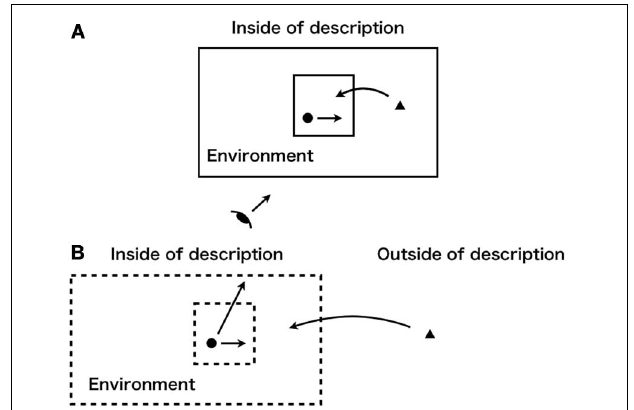
FIGURE 3 | Observer with partial knowledge (inner square of line or dotted line) is inside of the description and emergent properties originate from somewhere: schematic diagram of (A) transcendental view and (B) internal